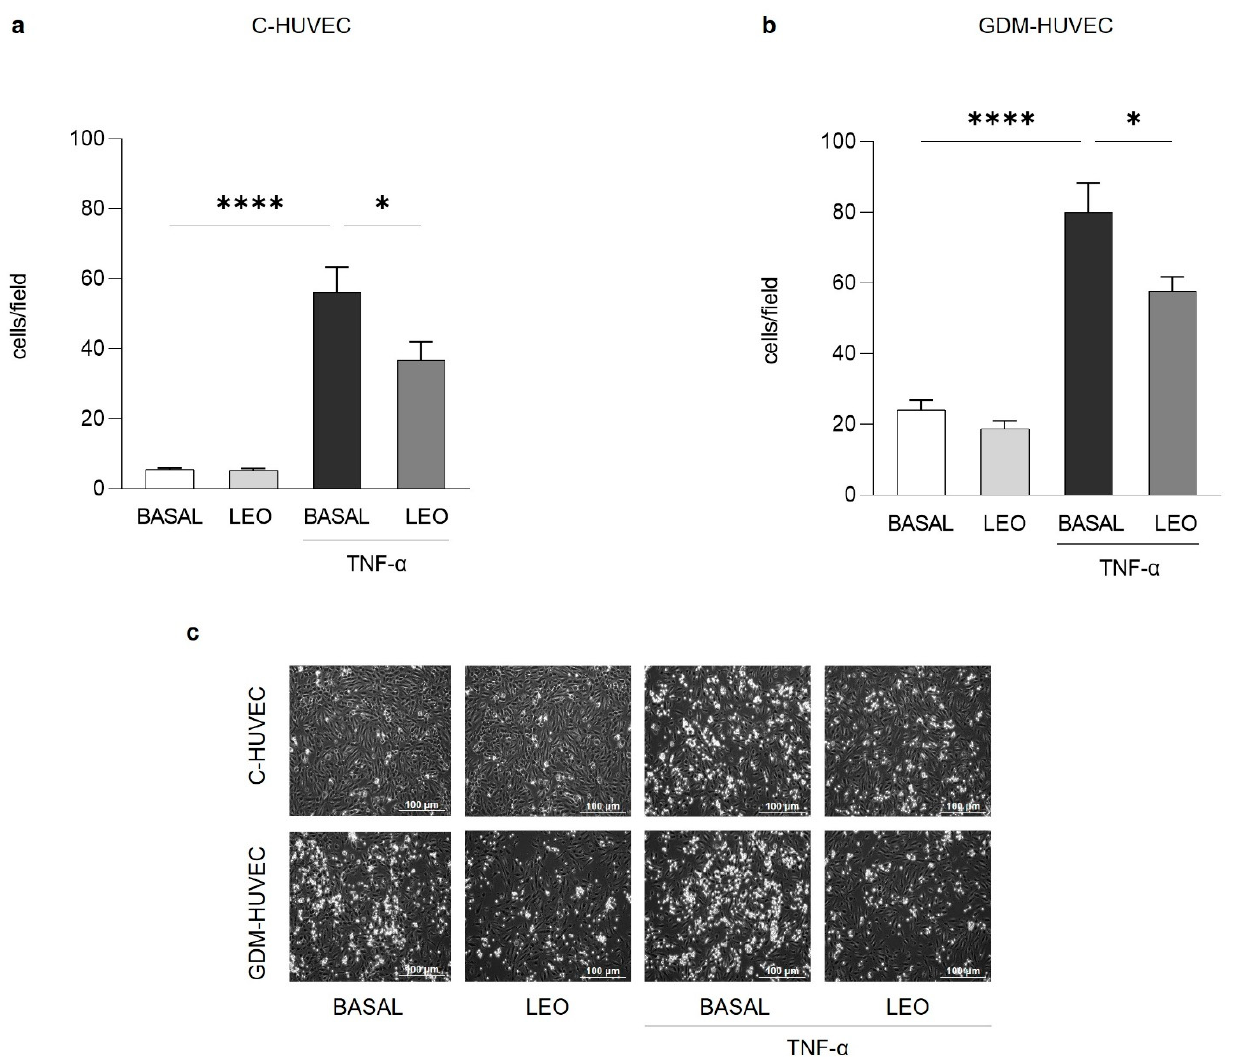
Figure 3. Effects of LEO on U937 monocyte adhesion to C- and GDM-HUVEC. Cells were serum- starved and incubated for 16h with TNF- α (1 ng/mL) following 24 h of pre-incubation with LEO (0.025% v / v ) or with medium alone (BASAL). Quantitative data express the number of U937 cells adhering within a high-power field (3.5 mm 2 ). Each measurement is expressed as mean ± SEM of adhering cells from 3 independent experiments, consisting of 8 counts per condition. ( a , b ) **** p < 0.0001 TNF- α vs. BASAL; * p < 0.05 TNF- α vs. TNF- α +LEO. ( c ) Representative images of U937 cell adhesion to C- and GDM-HUVEC. Scale bar: 100 µm.